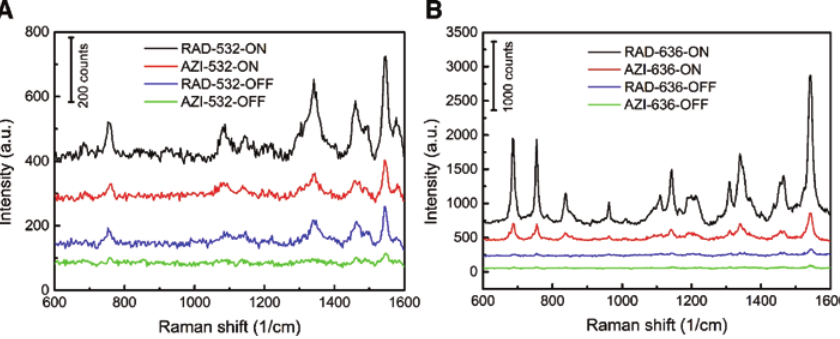
Figure 3: SERS spectra of CoPc on nanostructured Au. SERS spectra taken at different excitation wavelengths, namely (A) 532 nm and (B) 636 nm, incident polarizations, and locations. “ON” stands for spectra recorded from rectangular shaped bright areas, and “OFF” indicates the spectra recorded outside. The abbreviations “RAD” denotes the radially polarized mode, while “AZI” is the azimuthally polarized mode. Excitation power is 200 μ W, and integration time is 60 s. The background of each spectrum is